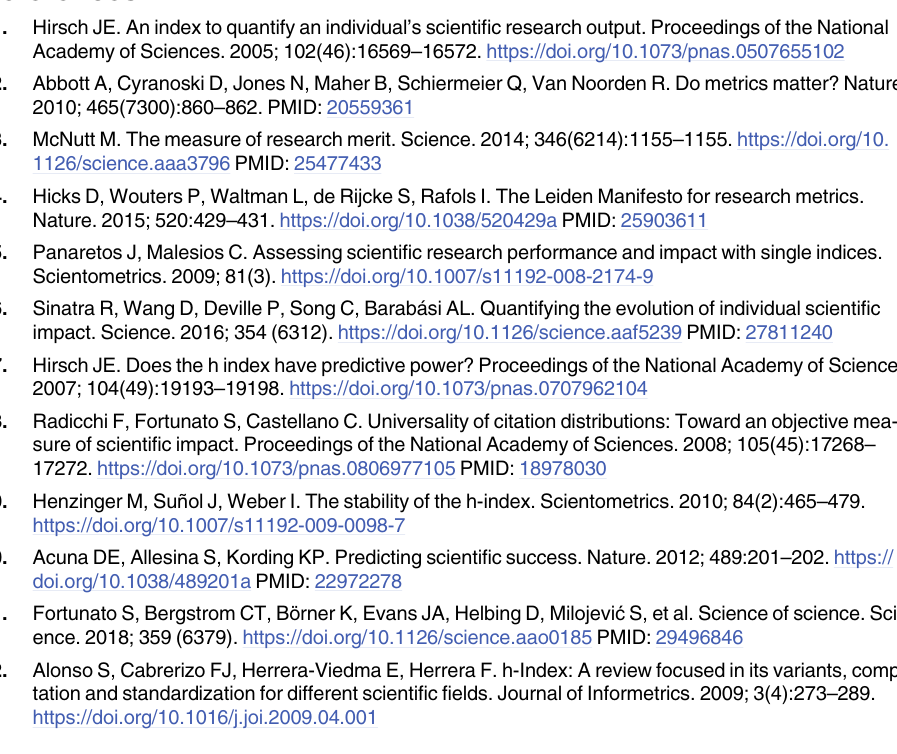
S2 Dataset. Sample of hyperauthors from the Scopus physics dataset that have > 2,441 coauthors per publication on average. Contains references to Scopus